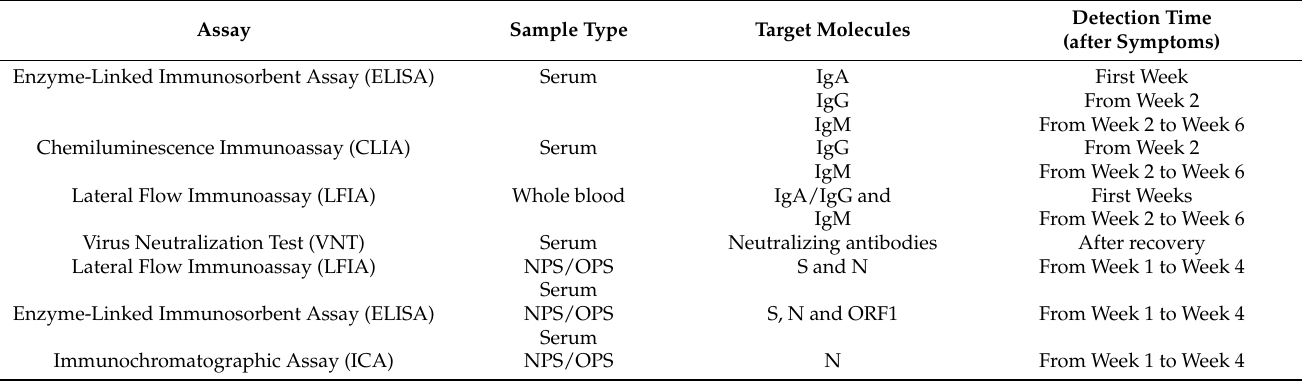
Table 1. Immunological diagnostics for SARS-CoV-2